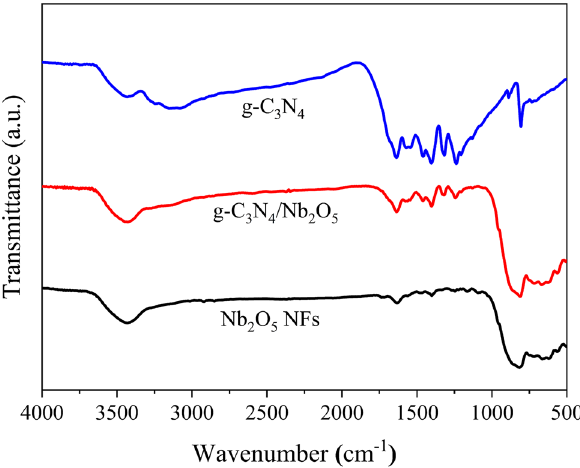
Figure 1. FTIR spectrum of g-C 3 N 4 , Nb 2 O 5 NFs and g-C 3 N 4 /Nb 2 O 5 heterojunction.